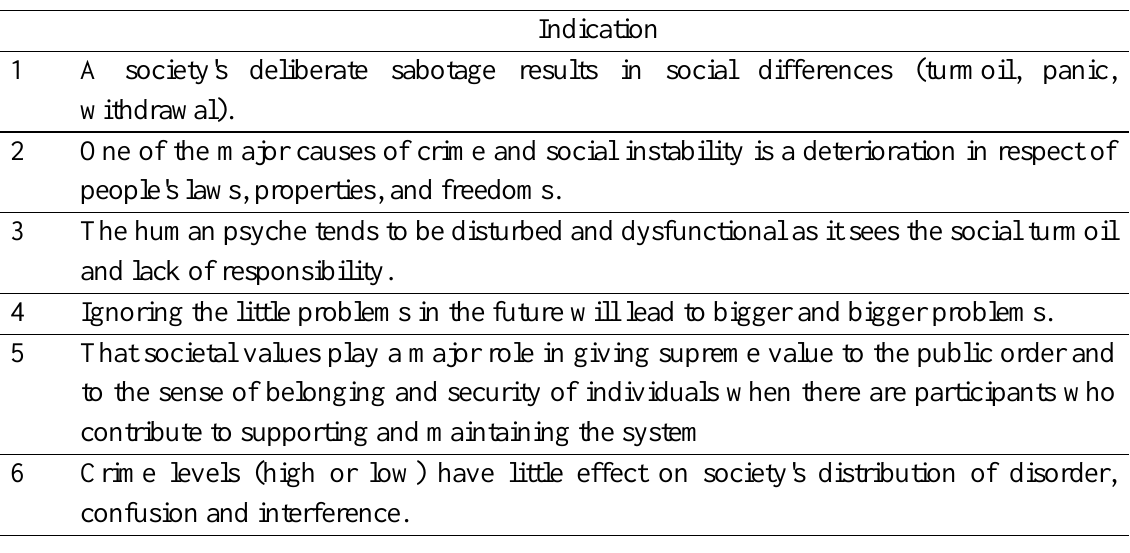
Table 1. The most important indicators derived from the broken windows theory, source: the researcher based on prior experiences.